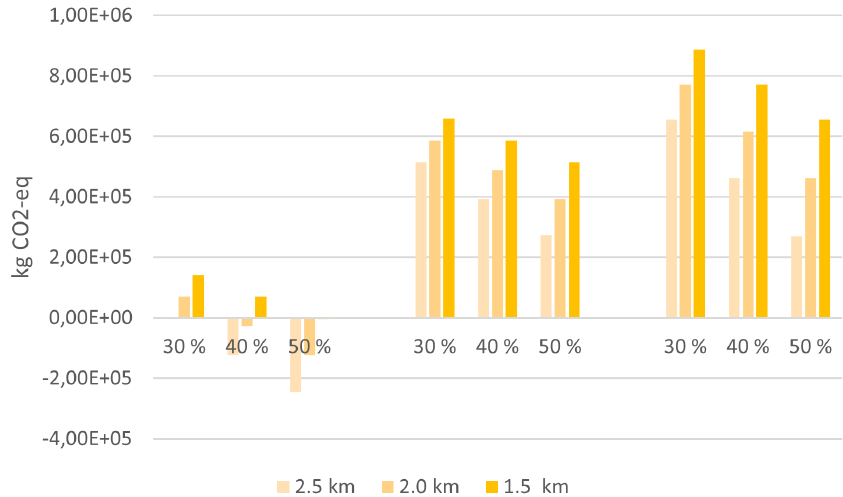
Figure 5. In the figure are the result for the first 30 years (left), the remaining 30 years (middle), and total emissions (right-hand side) when embodied emissions are assumed to increase due to more extensive refurbishments needed after 30